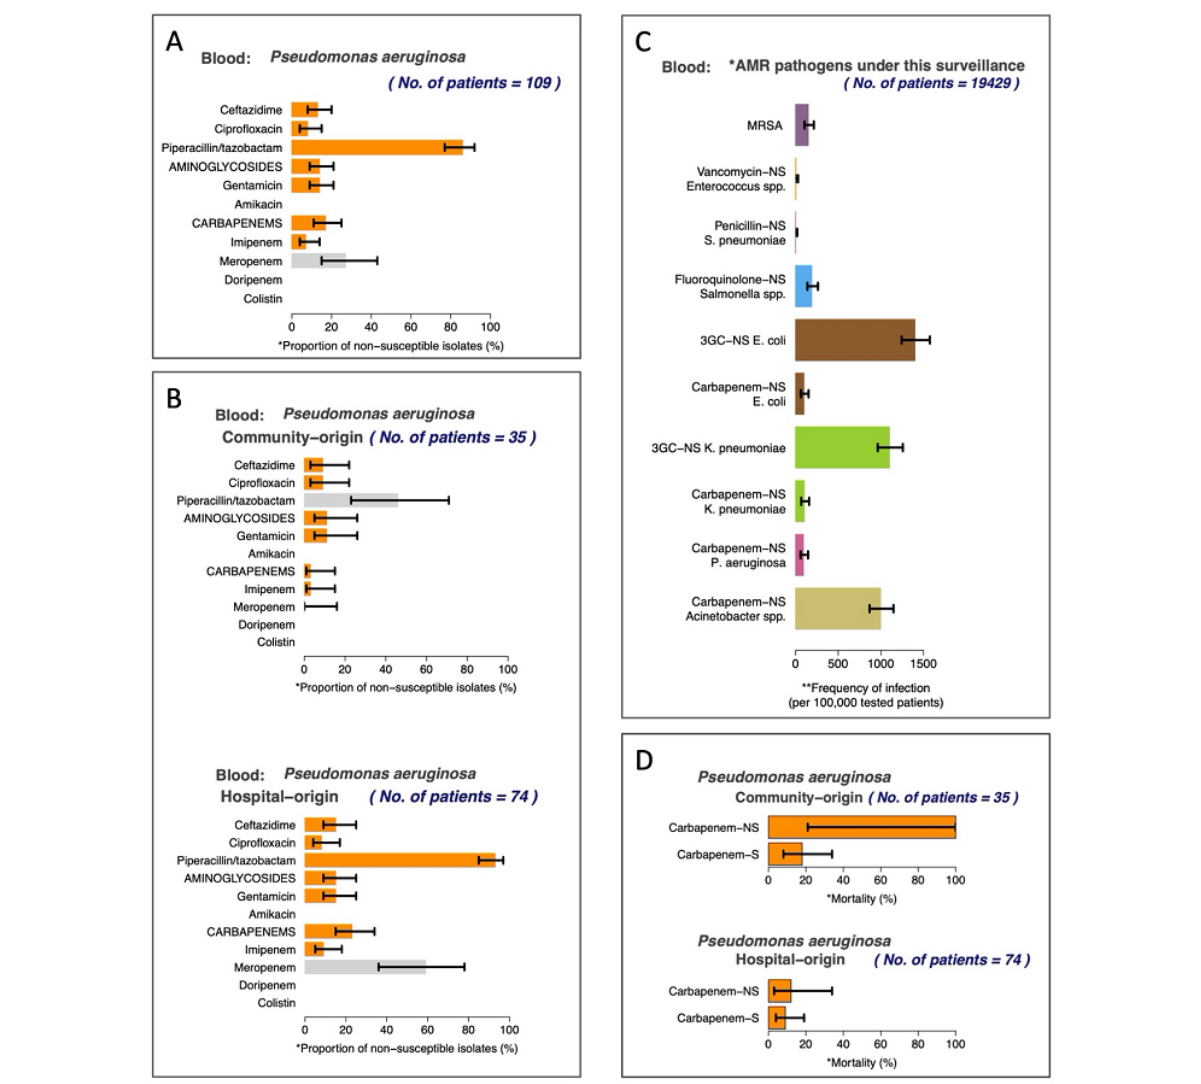
Figure 3. Examples of figures automatically generated by the AutoMated tool for Antimicrobial resistance Surveillance System (AMASS). All figures are from the report (Multimedia Appendix 8 Multimedia Appendix 8) automatically generated by the AMASS application using an example data set provided in the download package. Figure 3A represents the overall proportion of nonsusceptible (intermediate and resistant) isolates in an isolate-based report (section two in the report). Figure 3B represents the proportion of nonsusceptible isolates stratified by the origin of infection (section three in the report). Figure 3C represents the frequency of bloodstream infections per 100,000 tested patients (section four in the report). Figure 3D